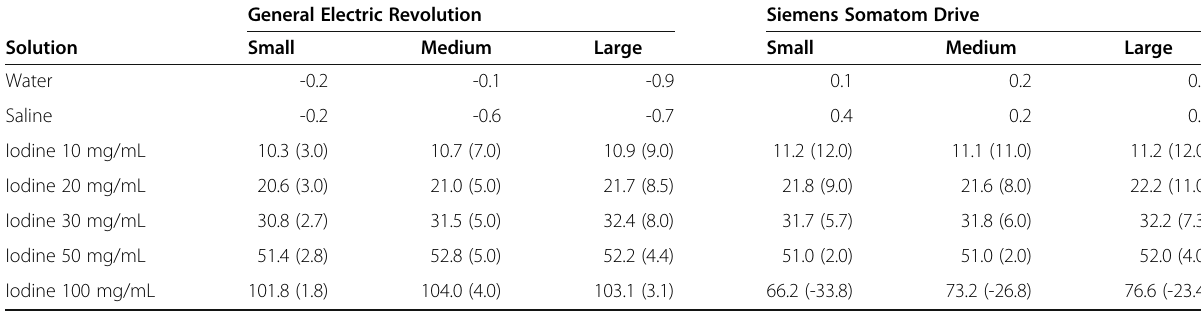
Table 2 Iodine concentration measurements for all concentrations (mg/mL) and phantom sizes General Electric